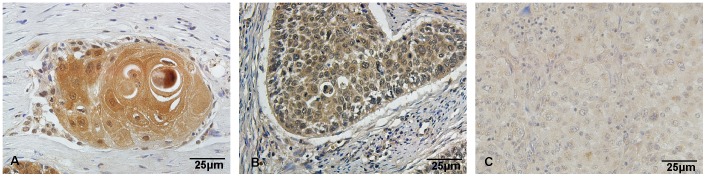
Kindlin-1 expression in different differentiation stages of squamous lung cancer.Representative photos reflecting Kindlin-1 expression in SCC have been selected and statistical analyses can be found in Table 2. A, Well differentiated SCC. B, Moderate differentiated SCC. C, Poorly differentiated SCC.